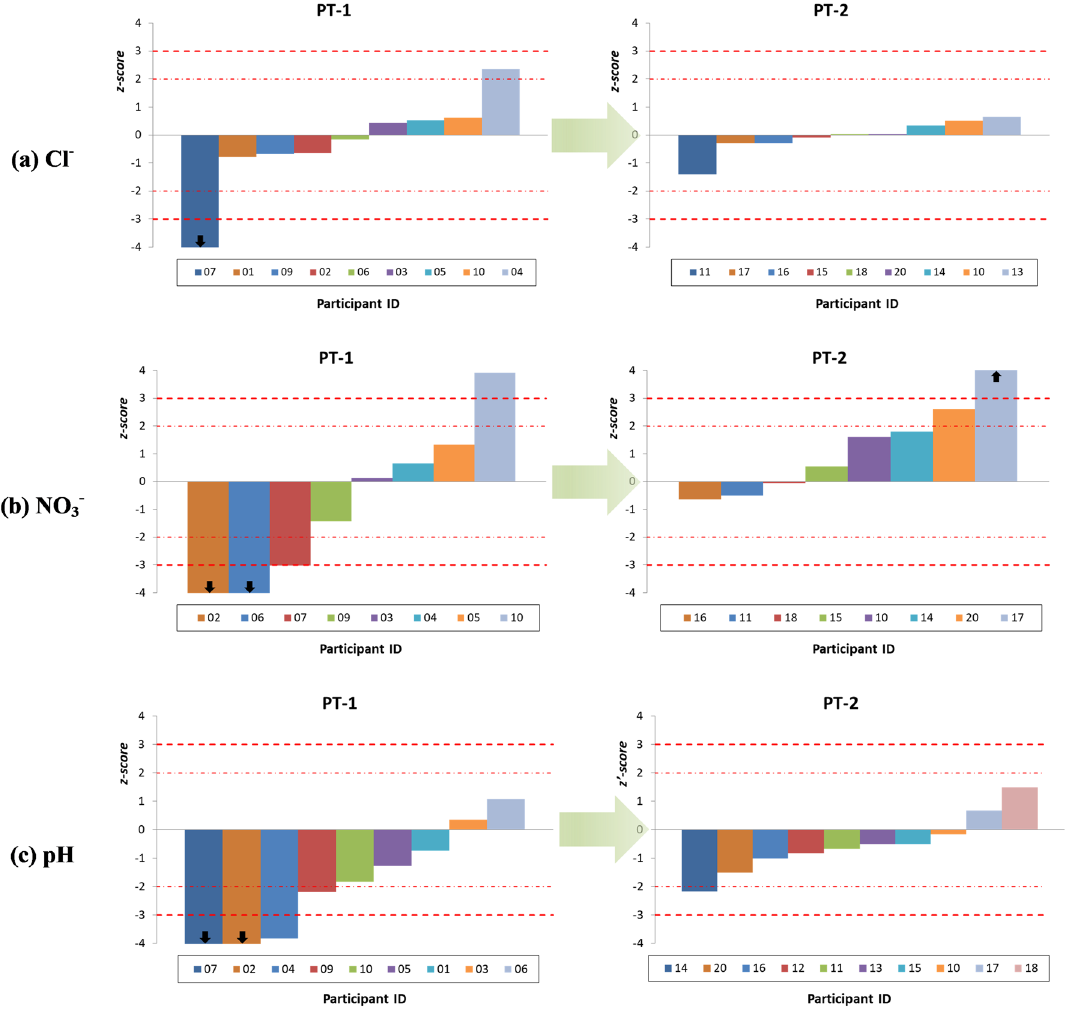
Figure 4. Improvement in performances of participants between PT-1 and PT-2 for rows ( a ) Cl − , ( b ) NO 3 − and ( c ) pH (arrows represent values outside axis